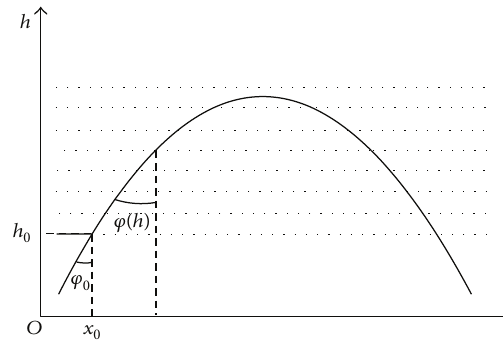
Figure 1: Flat, layered ionospheric medium described by a lin- earized profile (25a)-(25b) and (26a)-(26b) (reproduced from Set- timi et al.